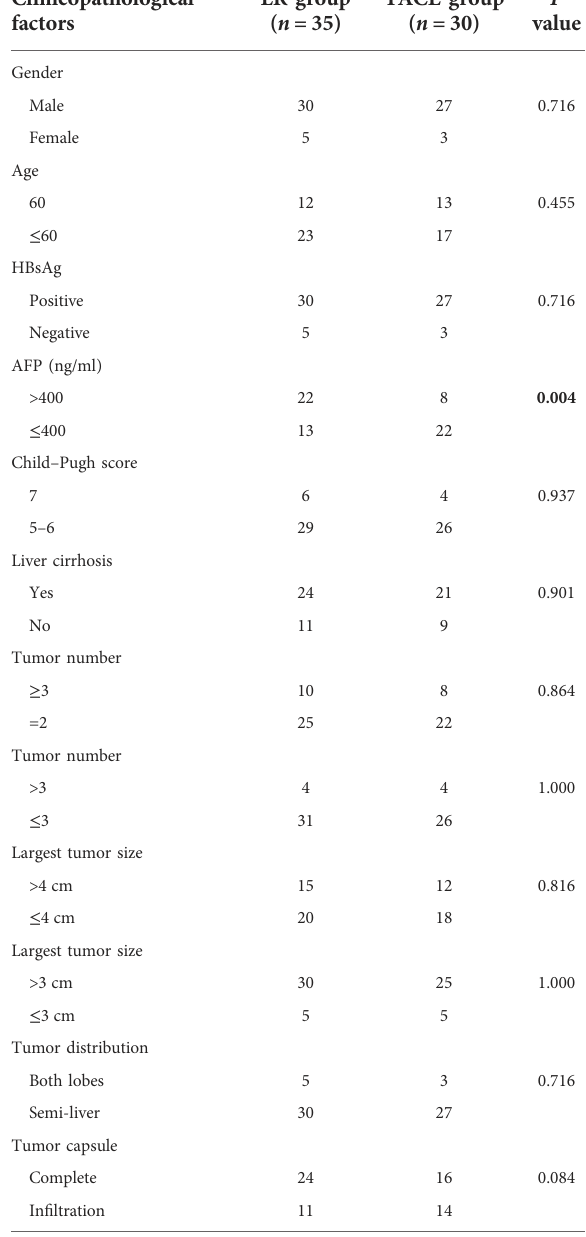
TABLE 2 Comparison of baseline characteristics of enrolled patients. Clinicopathological